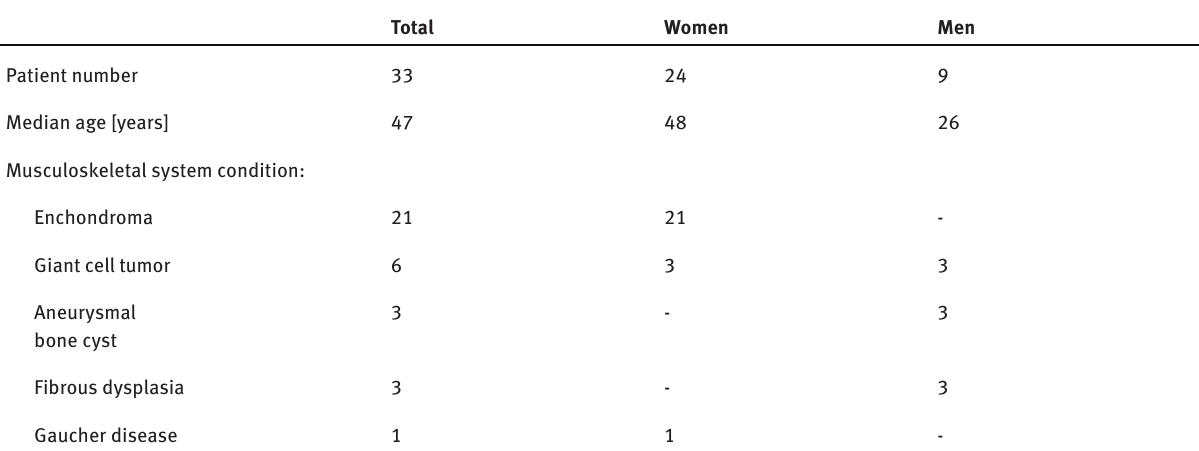
Table 1: Patient demographics and indications for